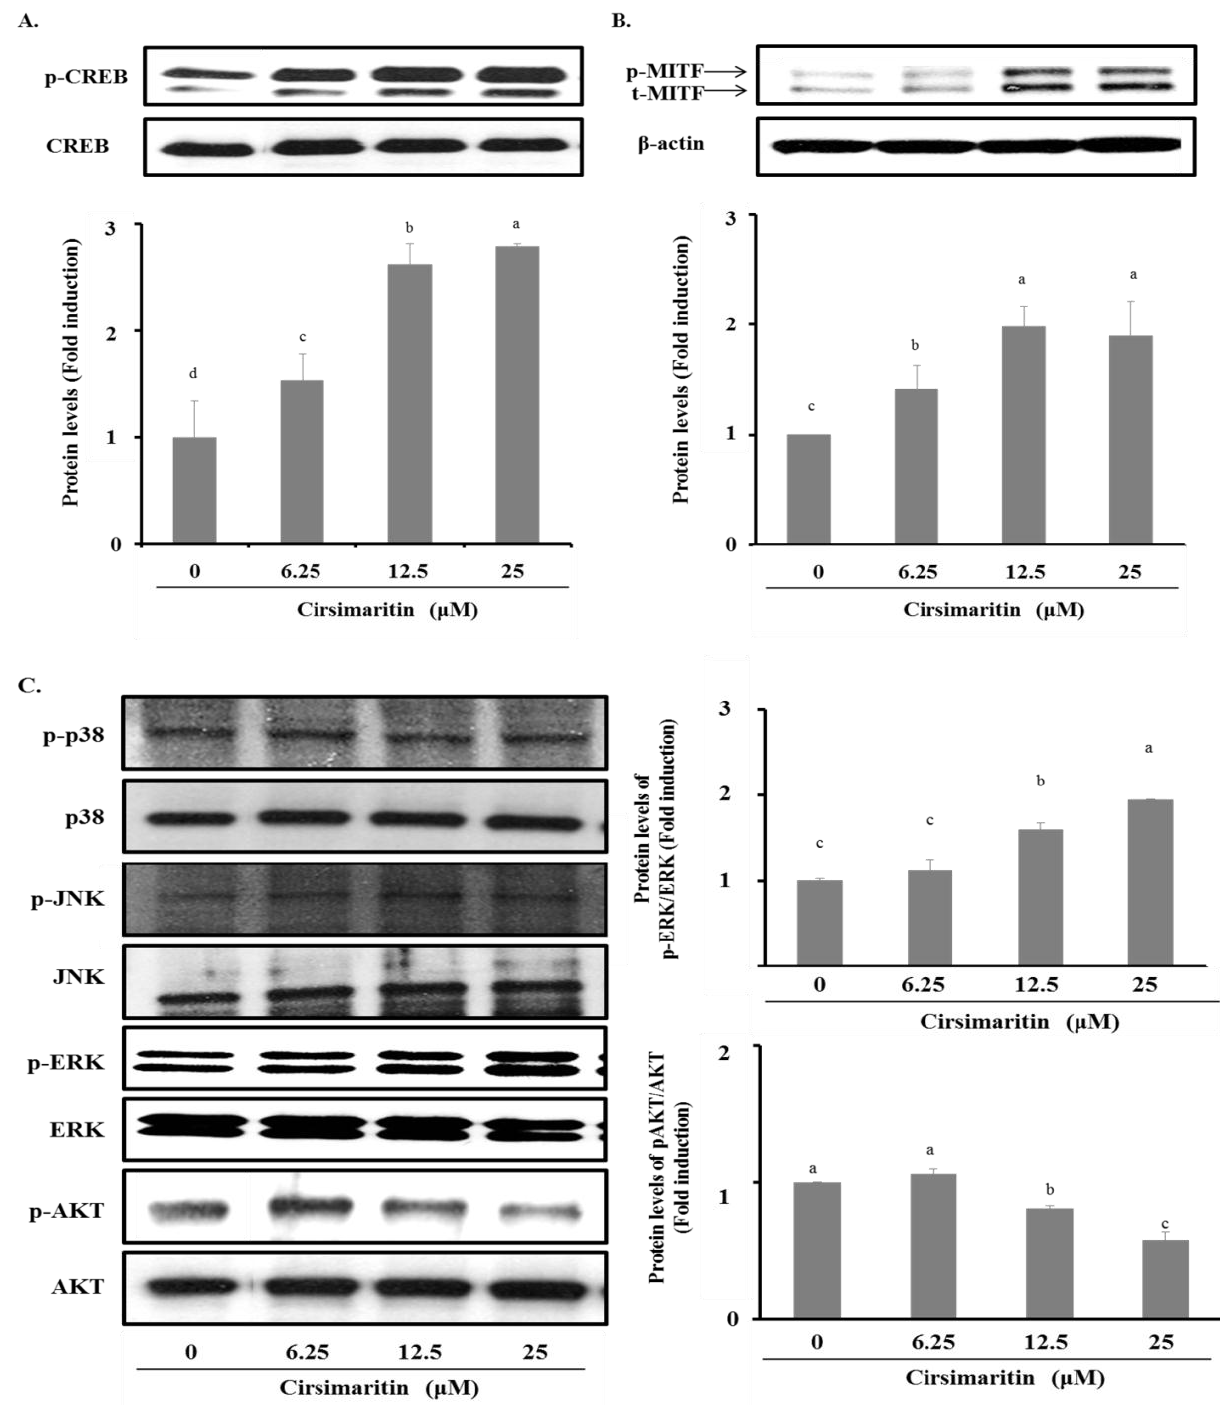
Figure 4. Effects of cirsimaritin on the phosphorylation of CREB and MAPKs, and the expression of MITF. Cells were treated with various concentrations of cirsimaritin for 1 h (p-CREB, p-ERK, and p-AKT) or 24 h (MITF), and then the protein expression levels were evaluated by western blotting. Bar graphs show densitometric evaluation of p-CREB ( A ); MITF ( B ); p-ERK and p-AKT ( C ) relative to CREB, β-actin, ERK, and AKT, respectively. Results are expressed as the means ± SD of three independent experiments. Means without a common letter differ, p <